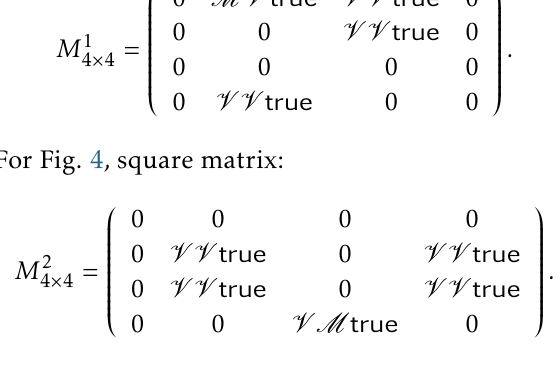
For Fig. 5, square matrix M (cid:80) × (cid:80)